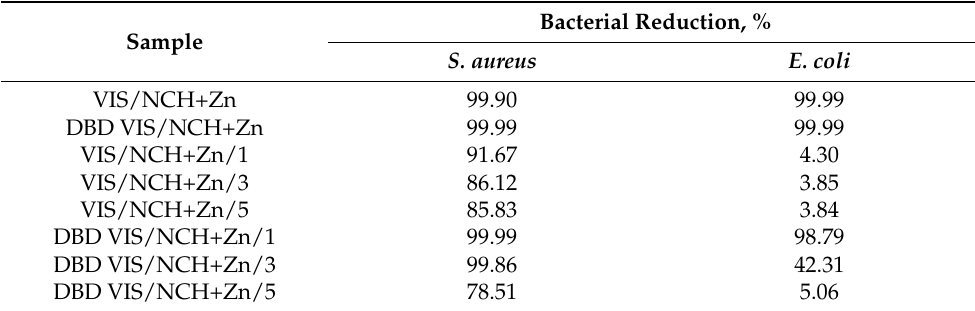
Table 4. The bacterial reduction by NCH+Zn-functionalized viscose fabrics. Part of results previously published in [6,11].